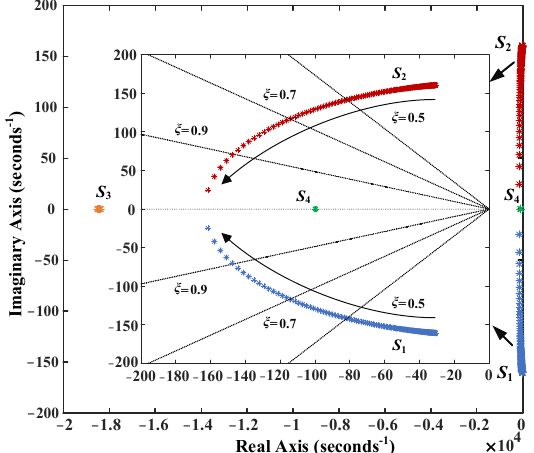
Figure 7. Characteristic root locus of the system with variation of W 4 .